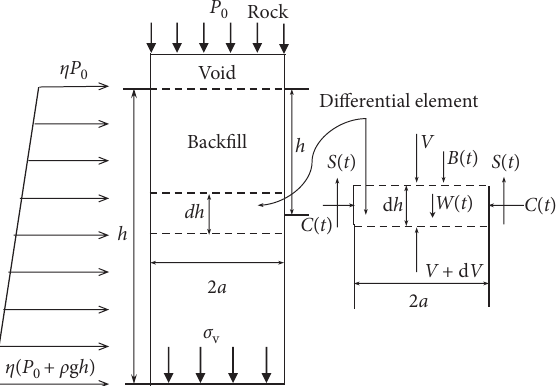
Figure 10: Diagram of approximate circular cross section high filling stope backfill